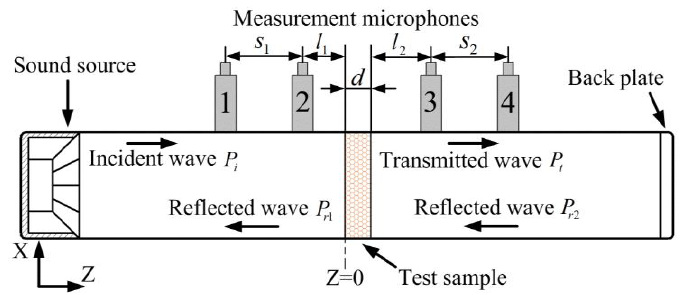
Figure 4. The impedance tube used in the experiments.